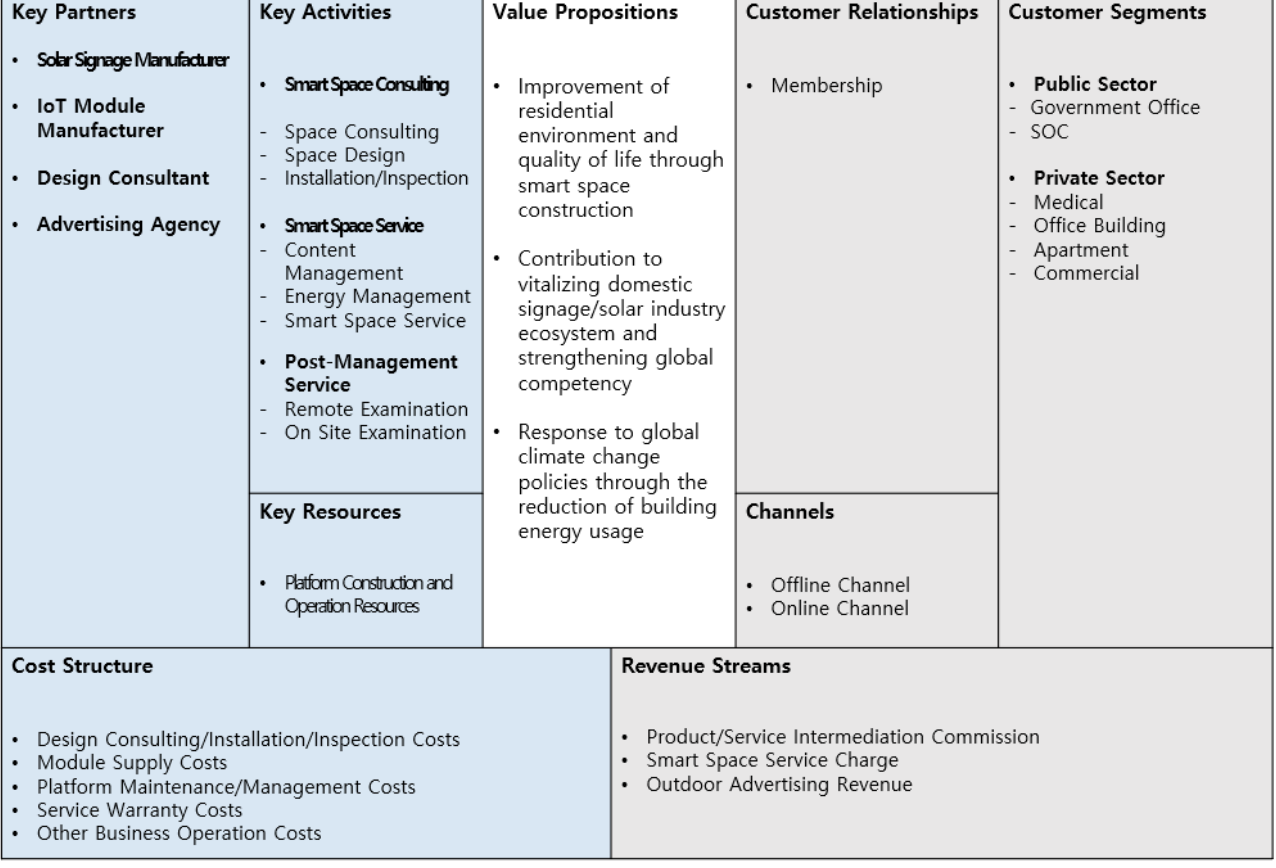
Figure 7. Business model canvas.